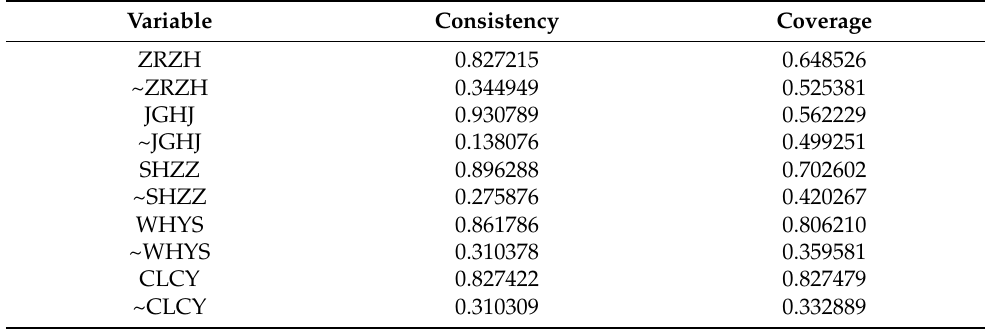
Table 6. Necessary conditions for each cause variable (BHFZ, high-level protection and development).